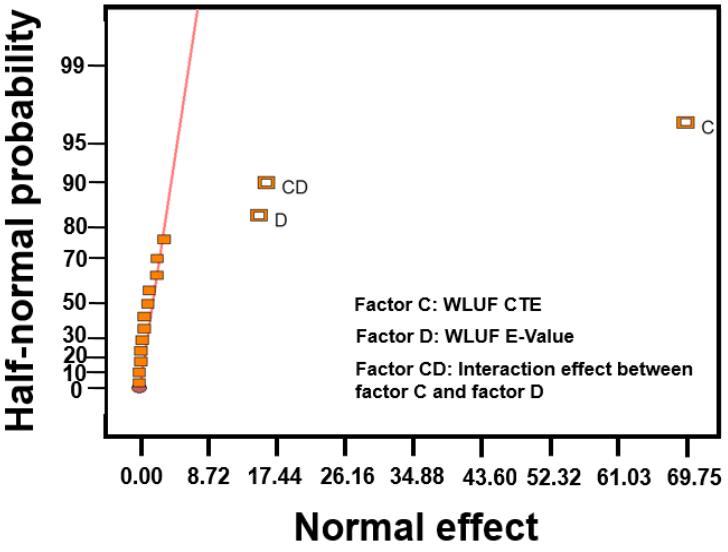
Figure 17. Half-normal probability plot for the equivalent plastic strain of outermost microbump at the proposed packaging